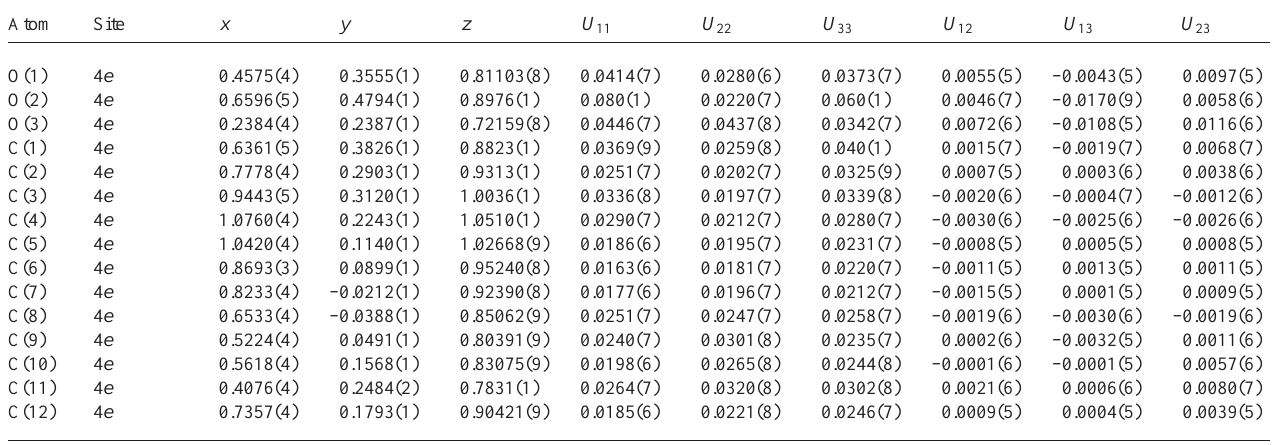
Table 3. Atomic coordinates and displacement parameters (in Å 2 )